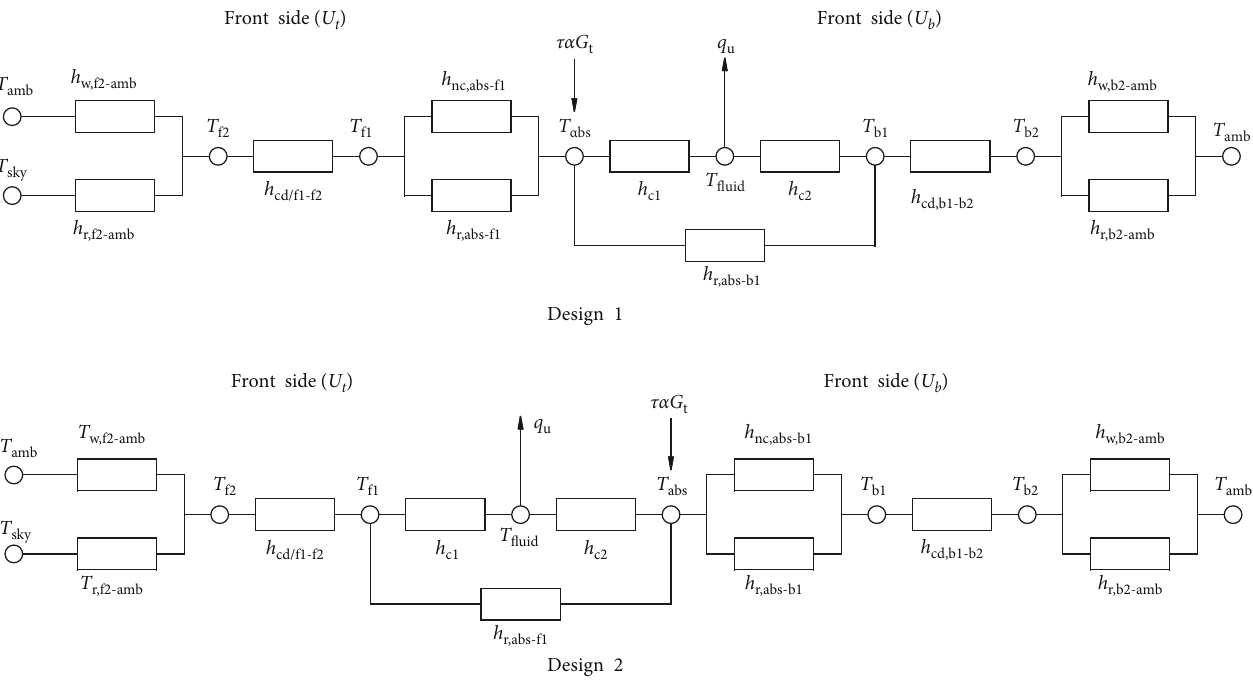
Figure 3: The thermal network of external energy balance if Operating Mode is equal to 0 — a liquid